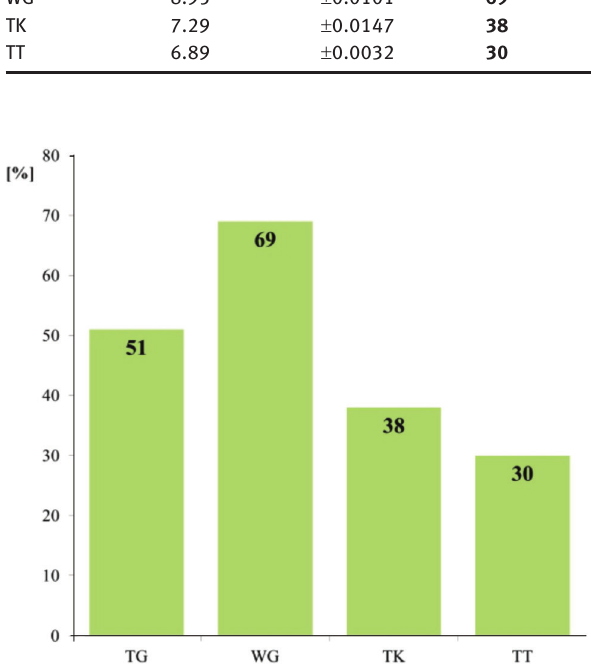
Fig. 9: Comparison of differences in the increase of microhardness of the refined glasses